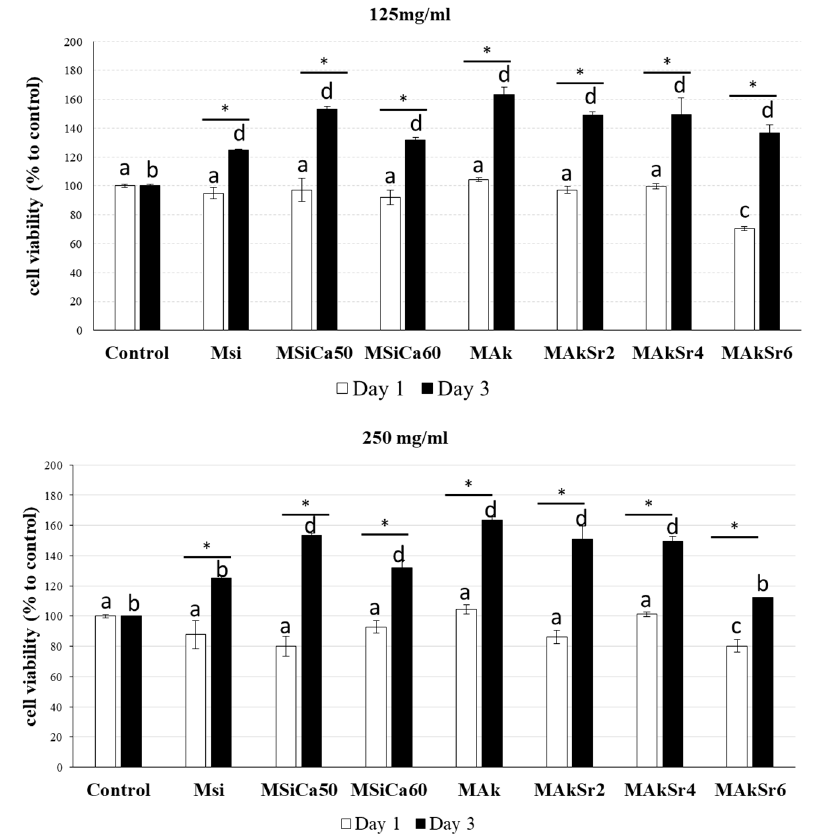
Figure 10. MTT results of cell viability at different concentrations of mesoporous silica-based nanoparticles (MSNs) ( μ g/mL). * indicates statistically significant difference ( p < 0.05) between Day 1 and Day 3, while different letter above columns indicates statistically significant differences from control at Day 1 ( a , c ) and Day 3 ( b , d ).